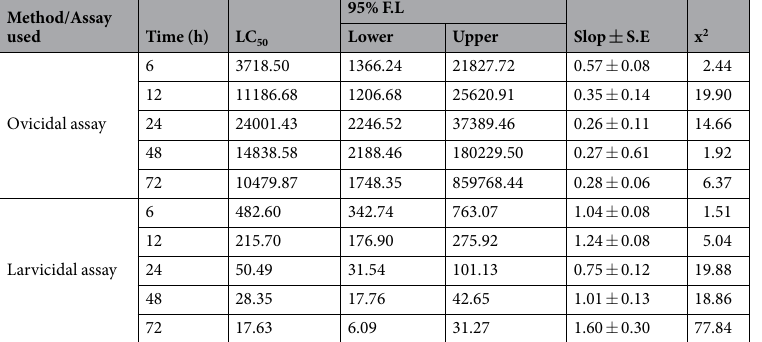
Exposure time (h)